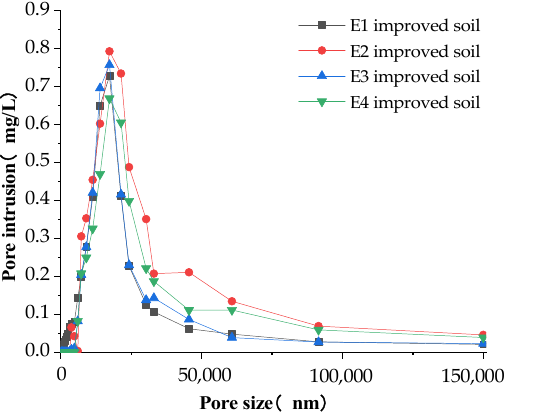
Figure 11. Pore distribution of soil amended with structural ameliorant.